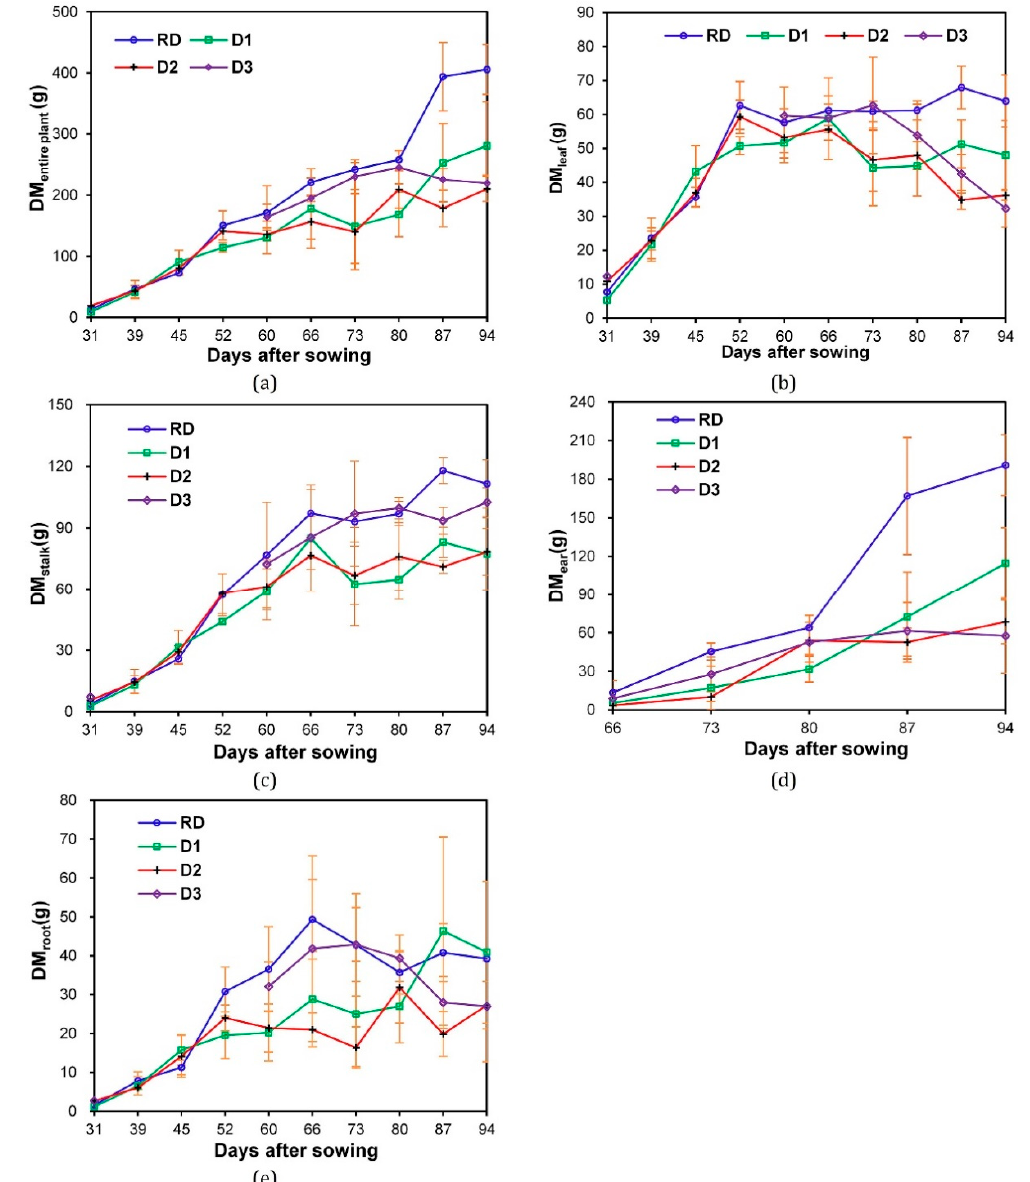
Figure 3. Impacts of drought stress on dry matters of various parts ( a ) entire plant, ( b ) leaf, ( c ) stalk, ( d ) ear, and ( e ) root.